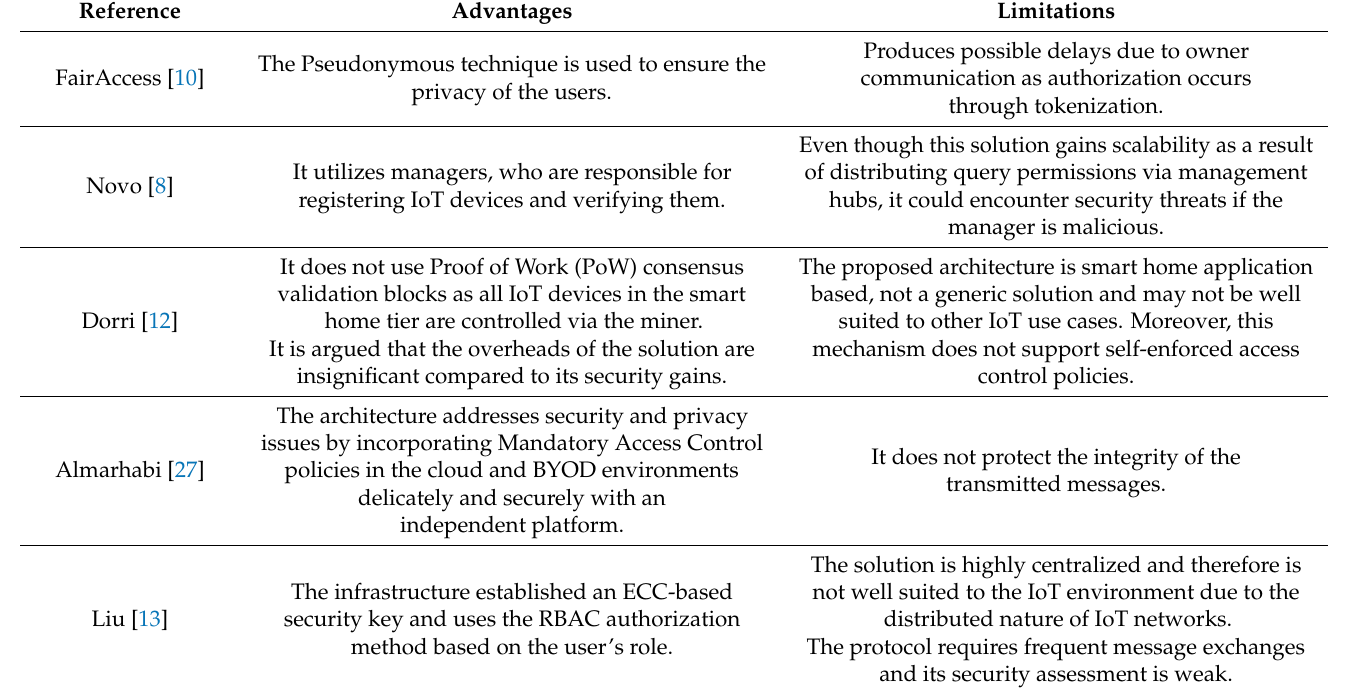
Table 2. Summary of the advantages and drawbacks of the related